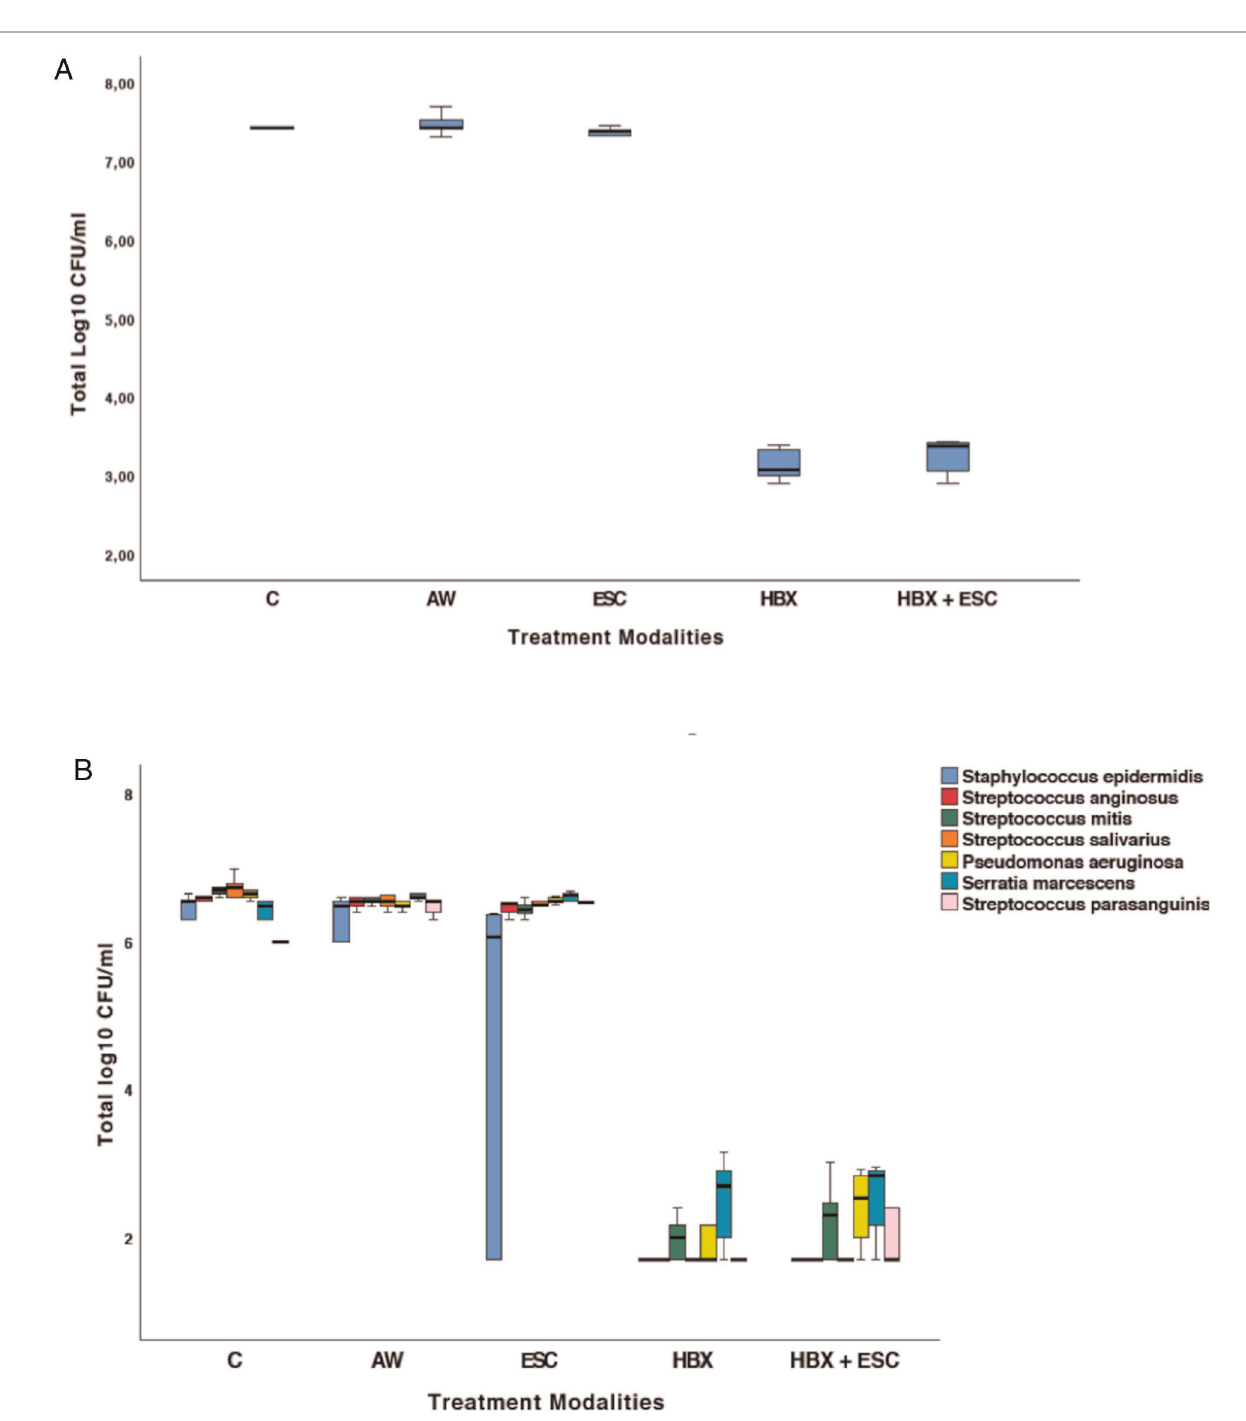
FIGURE 2 | ( A ) Total viable log 10 CFU/mL in the fi ve treatment groups. ( B ) Changes in terms of log 10 CFU/mL of S. epidermidis , S. anginosus , S. mitis , S. salivarius , P. aeruginosa , S. marcescens , and S. parasanguinis in the fi ve treatment groups. C, control group — no treatment; AW, air abrasion without powder; ESC, air abrasion with powder of erythritol, amorphous silica, and 0.3% chlorhexidine; HBX, sulfonic/sulfuric acid solution in gel alone; HBX+ESC, sulfonic/sulfuric acid solution in gel followed by air abrasion with powder of erythritol, amorphous silica, and 0.3%